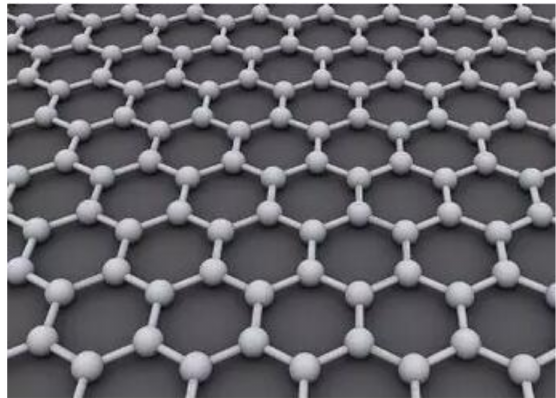
Figure 1. Schematic diagram of graphene structure.